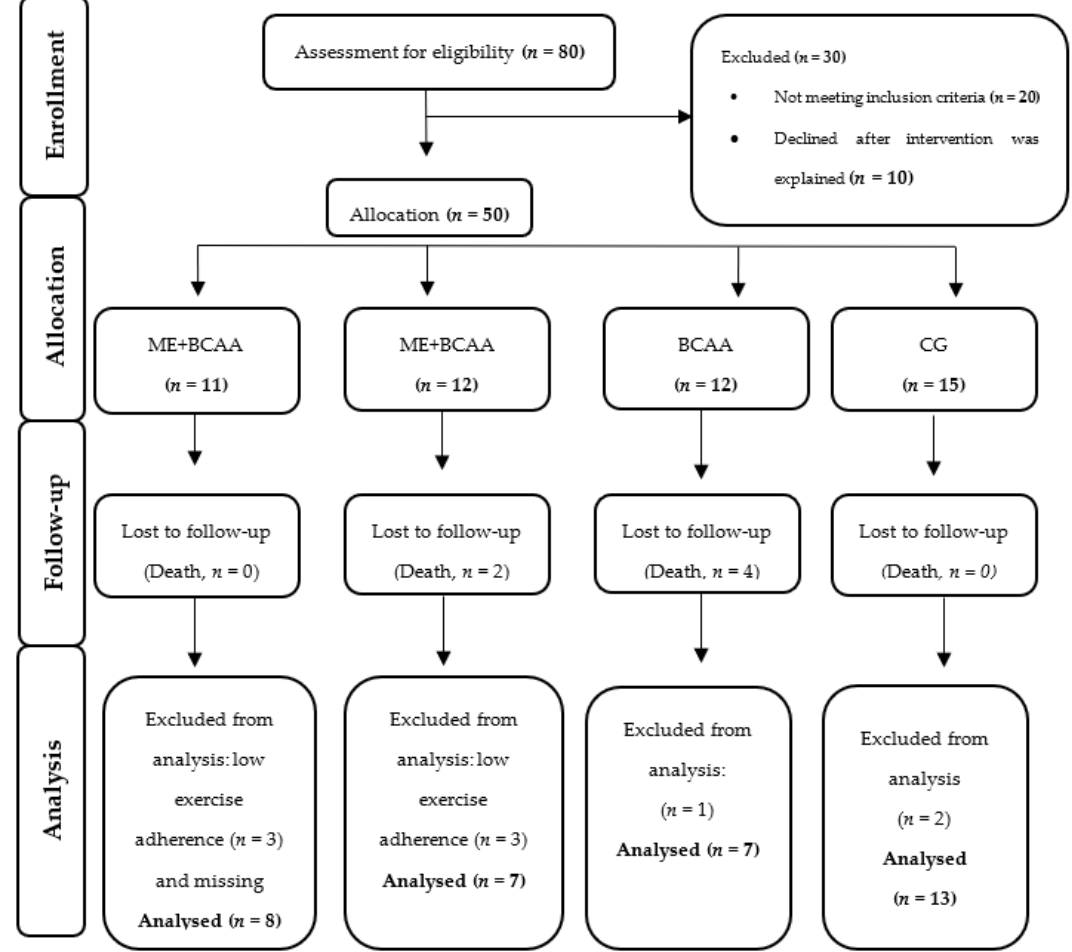
Figure 1. CONSORT Flowchart of study participants [30]. ME + BCAA, Multicomponent Exercise + Branched Chain Amino Acid; ME, Multicomponent Exercise; BCAA, Branched Chain Amino Acid; CG, Control Group.